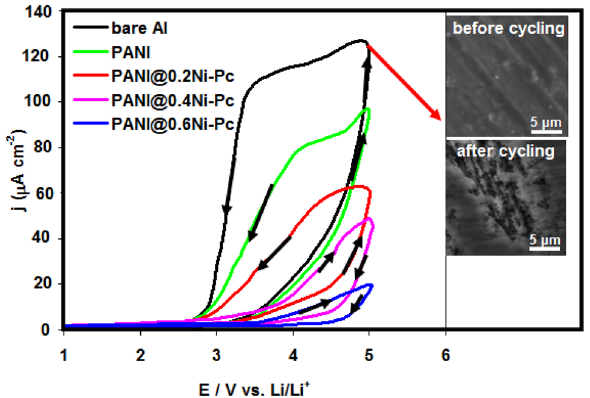
Figure 2. CV curves for pristine Al foil and coated Al foil with pristine PANI and PANI@Ni-Pc composites in LiN(SO 2 CF 3 ) 2 /EC:DMC (1:1 by vol.). Inset image shows SEM image of pristine Al foil in LiN(SO 2 CF 3 ) 2 before and after cycling.